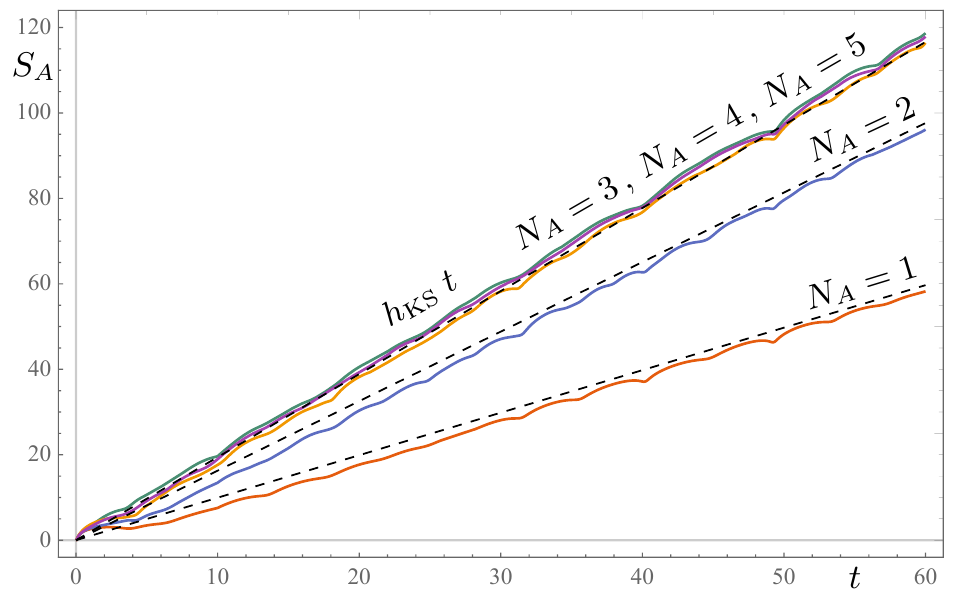
Figure 3 . Quadratic potential with instabilities . This plot compares the behavior of the en- tanglement entropy with the asymptotic prediction of our theorem. The system consists of N = 10 degrees of